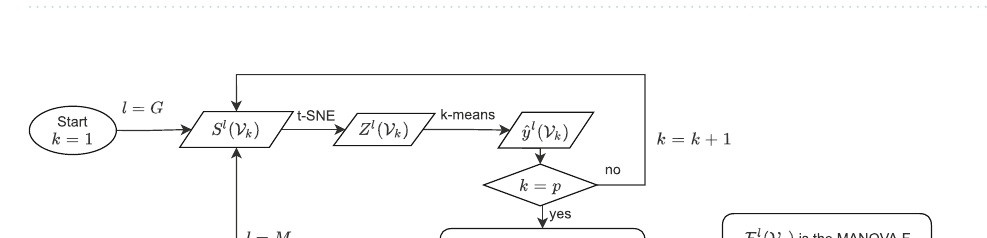
Table 1. Description of four scRNA-seq datasets.